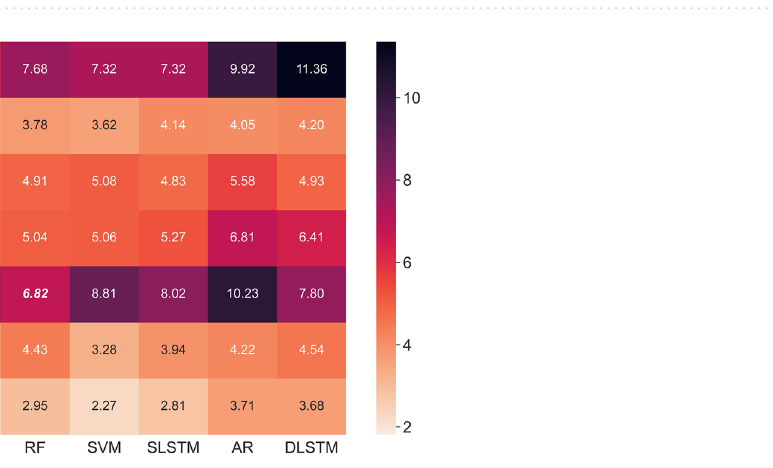
Figure 5. The forecasts of a hybrid model versus the ground truth, and the contribution of its AR and its LSTM component.